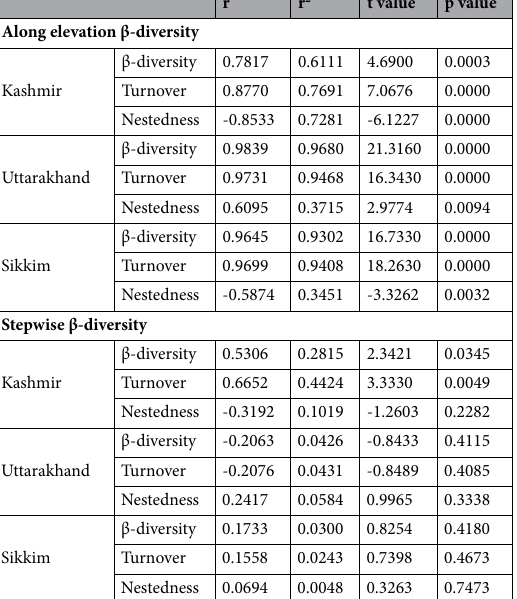
Table 5. Results of linear effect models testing the effect of elevational distance for overall β-diversity (β sor ) and the components turnover (β sim ) and nestedness (β sne ) performed separately for along elevation and stepwise